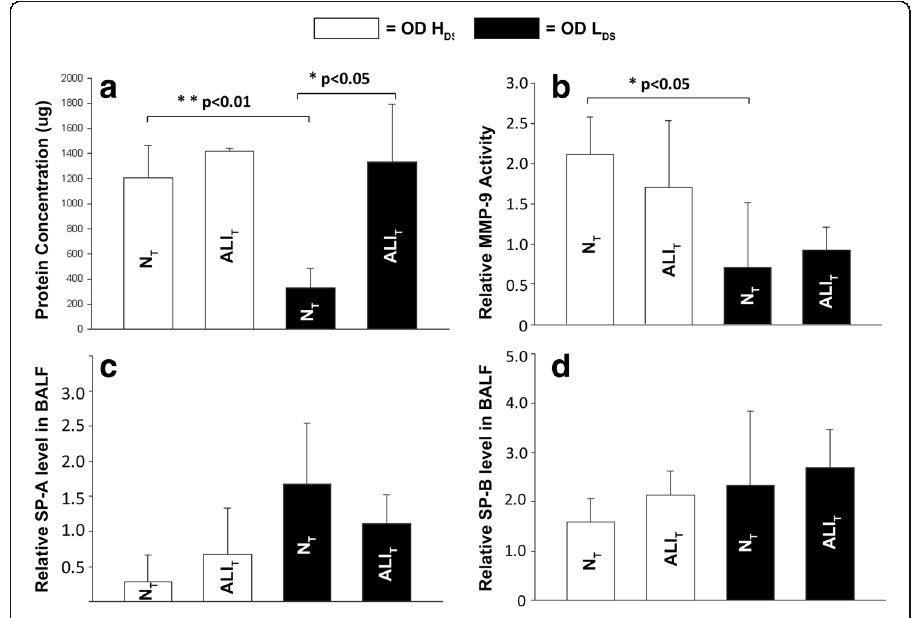
Fig. 3 The effect of both high ( OD + H DS ) and low ( OD + L DS ) dynamic strain on total protein concentration, matrix metalloproteinase-9 ( MMP-9 ) activity, and both surfactant protein A ( SP-A ) and B ( SP-B ) levels in bronchoalveolar lavage fluid ( BALF ) of normal ( N T ) and acutely injured ( ALI T ) lung tissue. a Low dynamic strain (OD + L DS ) prevented the increase in total protein in normal lung tissue (N T ). b Low dynamic strain (OD + L DS ) prevented the increase in MMP-9 activity in N T . c High dynamic strain (OD + H DS ) caused a decrease in SP-A in N T . d No differences in SP-B were seen with high or low dynamic strain or in normal or acutely injured lung tissue. Data mean ± SD